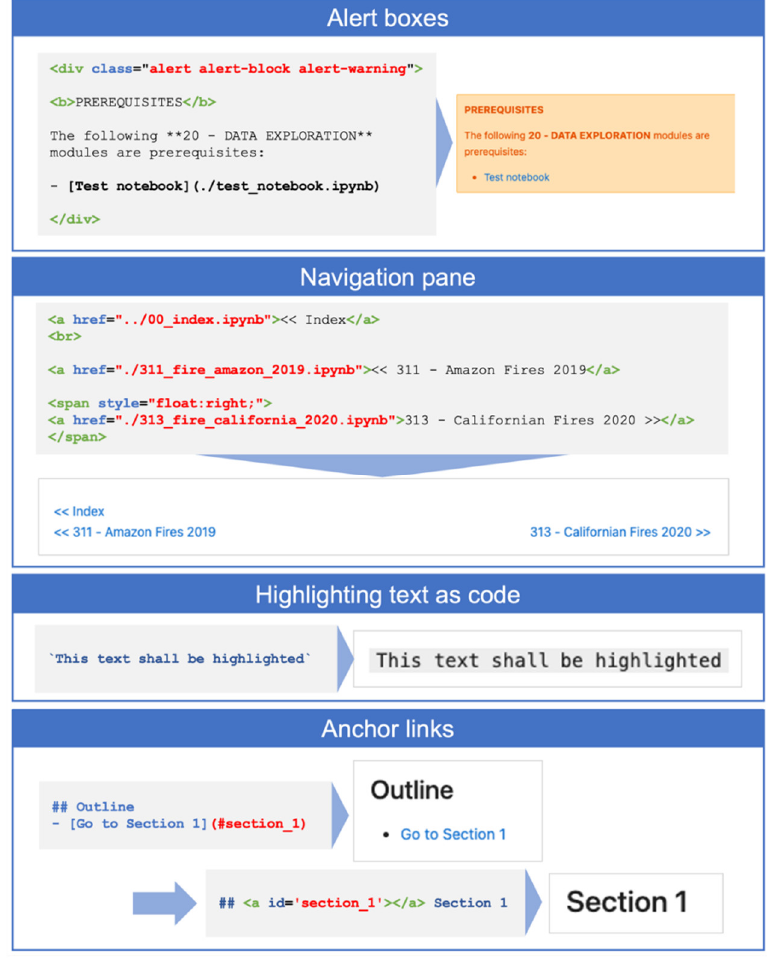
Figure 5. Overview of HTML/Markdown commands, which were used as instructional design elements, and their rendered output: (i) alert boxes, (ii) navigation pane, (iii) highlighting text as code and (iv) anchor links.